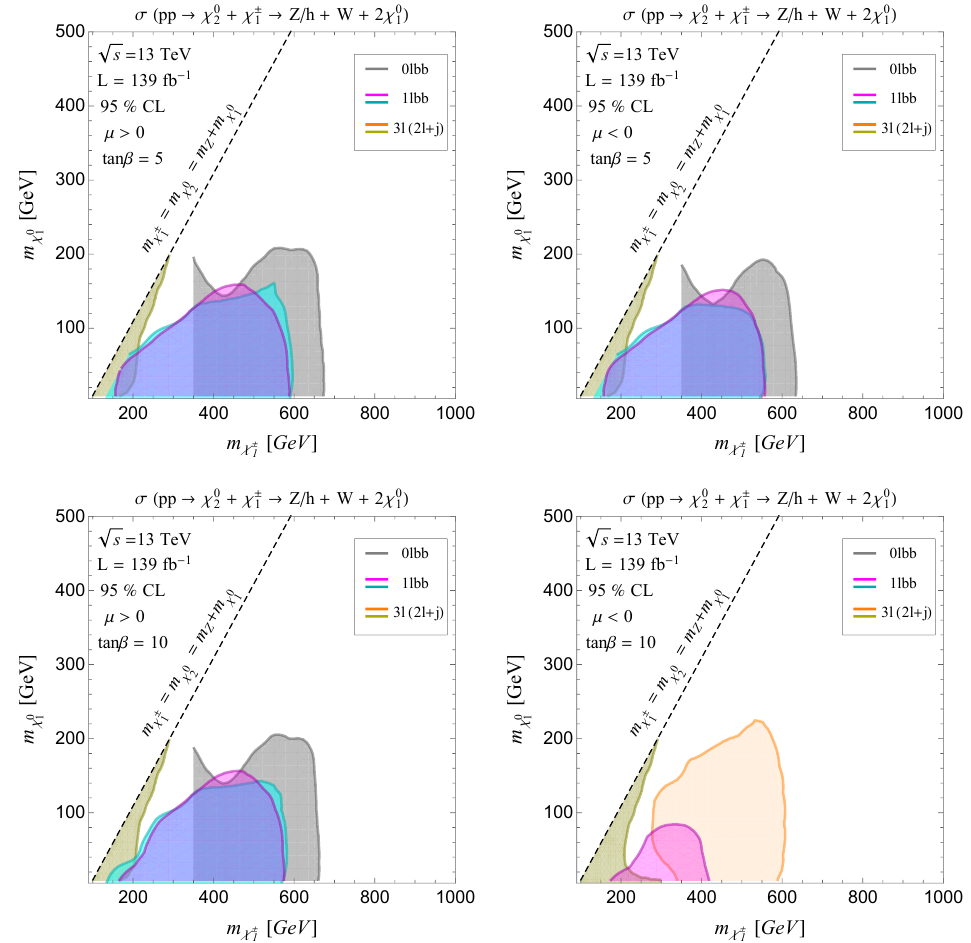
Figure 5 . 95% confidence level bounds on the Wino-Bino scenario projected to integrated lumi- nosity L = 139 fb − 1 . In the top (bottom) panel, we show the bounds for tan β = 5 ( tan β = 10 ) and M SUSY = | µ | = 2 TeV. The 0 ‘bb (gray) [16] and 1 ‘bb (magenta, cyan) [16, 17] bounds are projected from searches of the χ 0 χ ± → hW + 2 χ 0 channel, with h → ¯ bb and W decay to hadronic or leptonic 2 1 1 final states. The 3 ‘ (dark yellow) [19] and 3 ‘/ 2 ‘ + j (orange) [15] bounds are projected from the χ 0 χ ± → ZW + 2 χ 0 channel, with Z → 2 ‘ 2 1 1